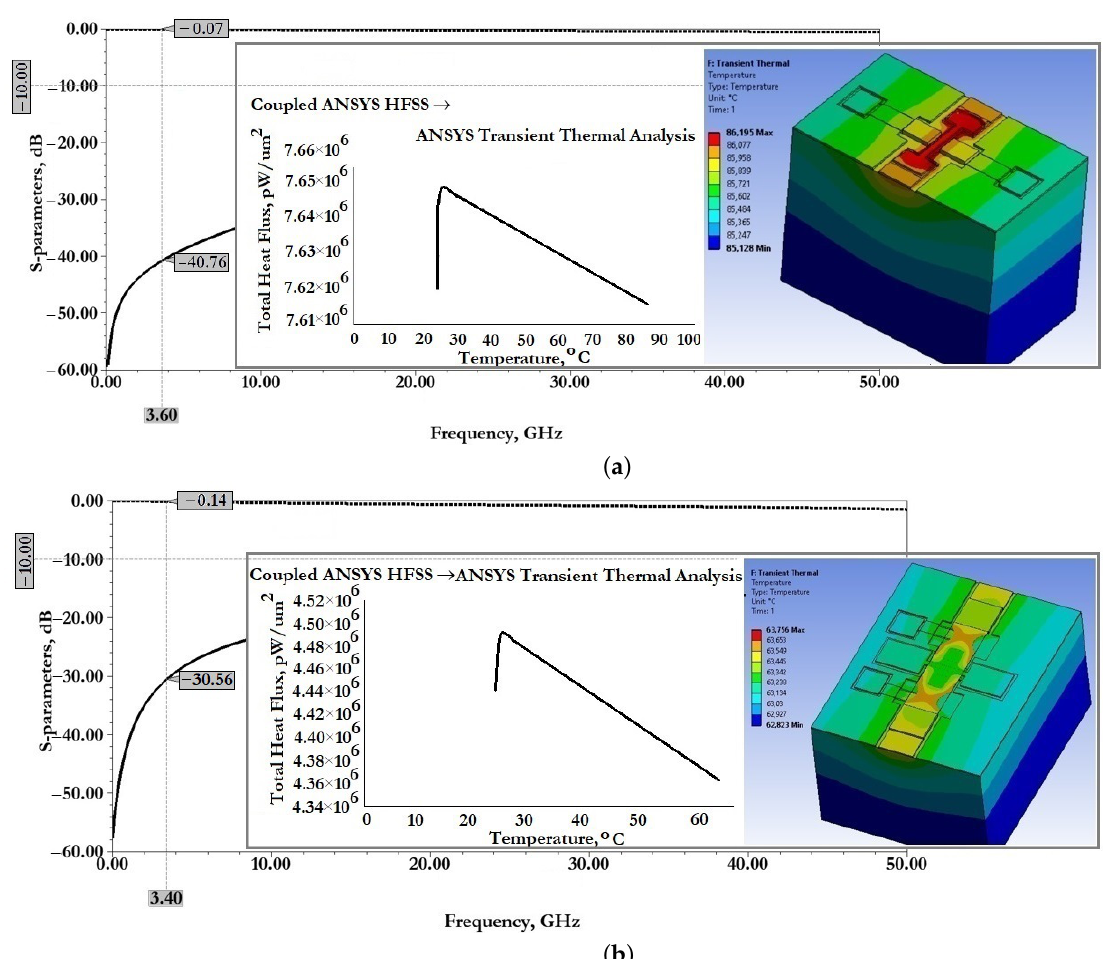
Figure 20. The results of EM and transient thermal modeling of CPW (A) and CPW (B) including fixed down actuation electrodes, contact pads, contact lines and MIM capacitor: ( a ) switch (A); ( b ) switch